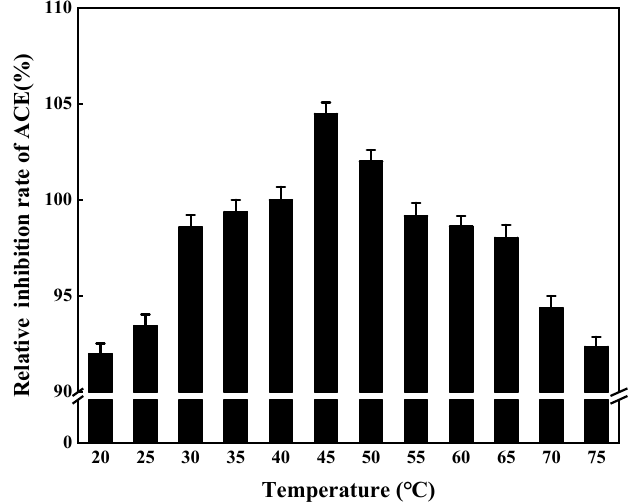
Figure 17. Stability of ACE inhibitory peptide at different temperatures.